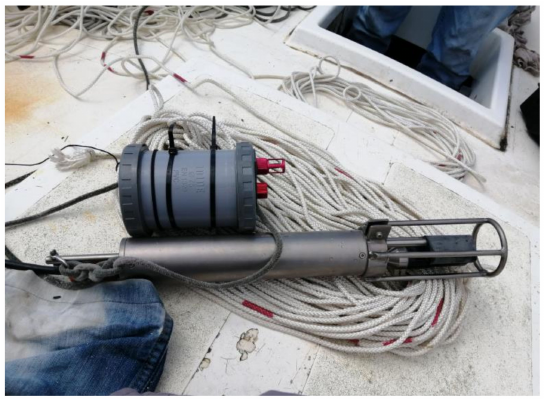
Figure 4. SPV TD aside the Sea & Sun CTD 48Mc probe; the respective lengths are approximately 20 cm and 45 cm